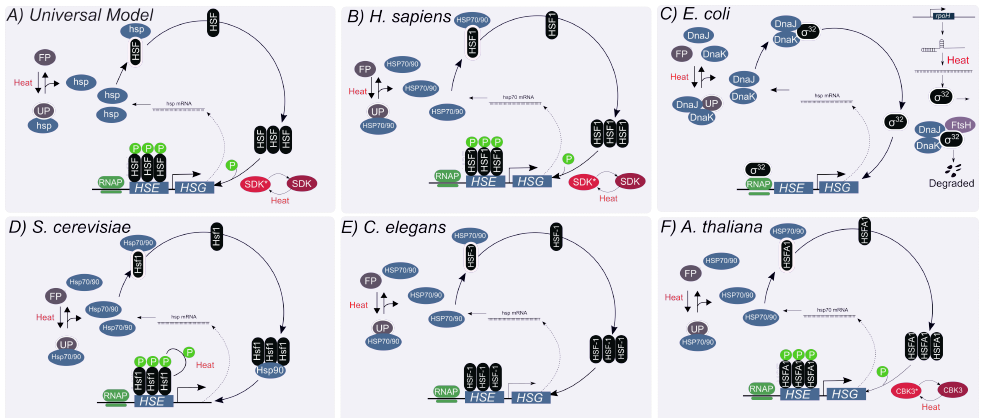
Figure 1. Overview of the HSR Model. The central element of HSR is the stress-induced activation of the heat-shock transcription factor, HSF, resulting in the initiation of heat shock proteins (HSP) synthesis. The respective core model of HSR in different model organisms is represented. UP: Unfolded protein, FP: Folded proteins, p (cid:13) : phosphorylation, SDK and CBK3: inactive protein kinase, SDK* and CBK3*: active protein